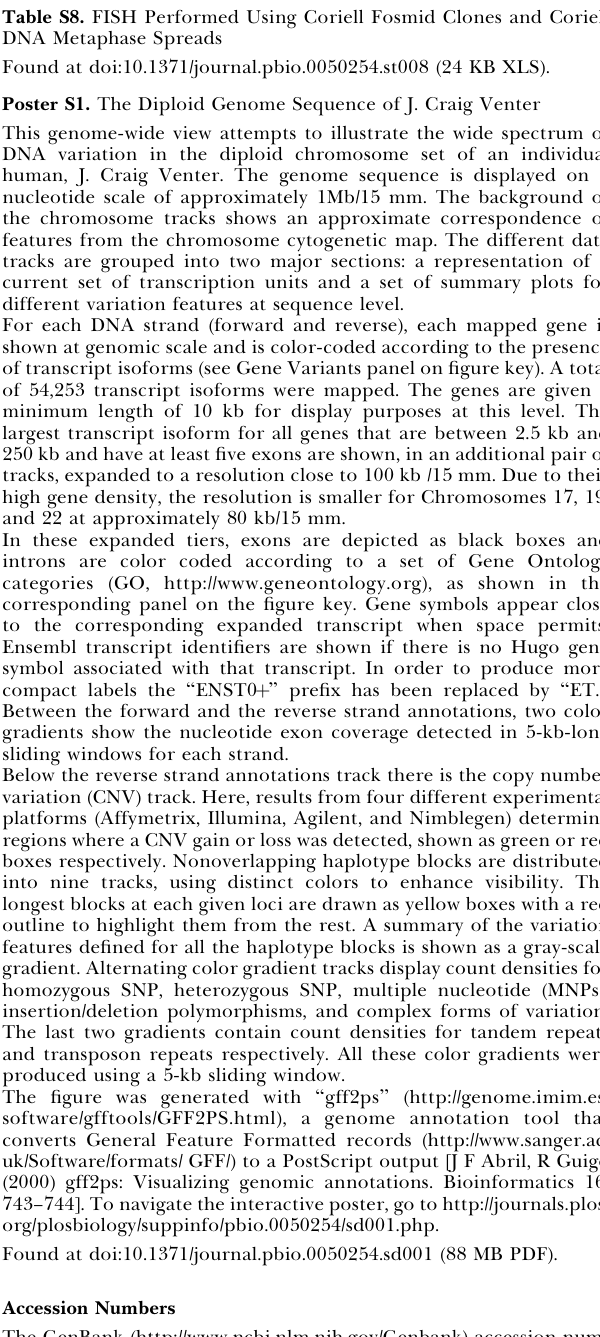
Table S6. Homozygous Insertions Tested in 93 Coriell DNA Samples and the HuRef Donor DNA I/I provides the number of Coriell DNA samples that are homozygous for the inserted sequence, heterozygous (I/N), and homozygous for no insertion (N/N). The Hardy-Weinberg p -value is based on CEU individuals.